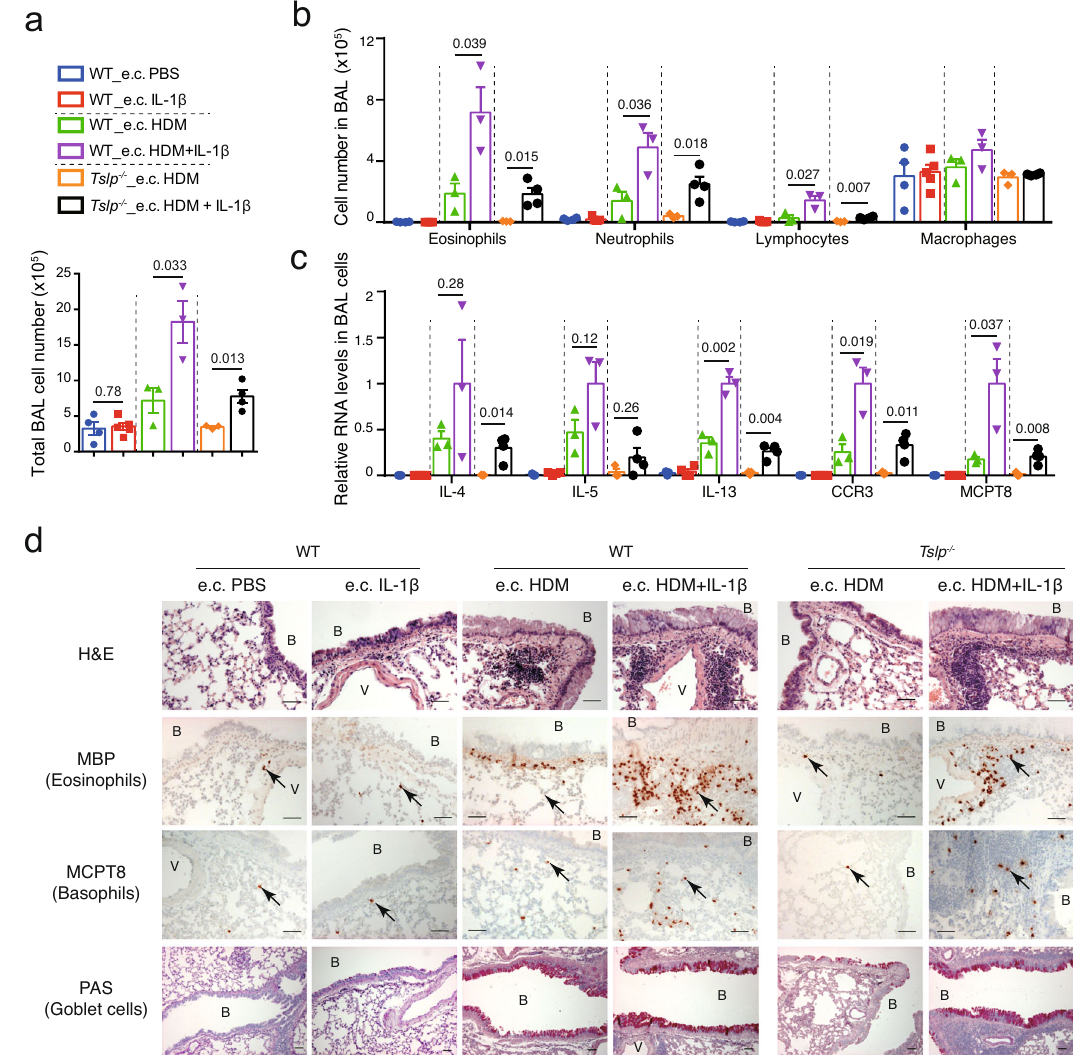
Fig. 4 | Co-administration of IL-1 β exacerbates e.c. HDM-induced asthmatic in fl ammation in a TSLP-independent manner. a Total cell number in BAL fl uid. b Cell number of eosinophils, neutrophils, lymphocytes and macrophages in BAL fl uid. For a , b n =4, 5, 3, 3, 3, 4 mice. c Quantitative RT-PCR analyses of BAL cells ( n =3,4,3,3,3,4mice).Graphsin a – c showmean±SEM.Two-sidedStudent ’ s t -test.